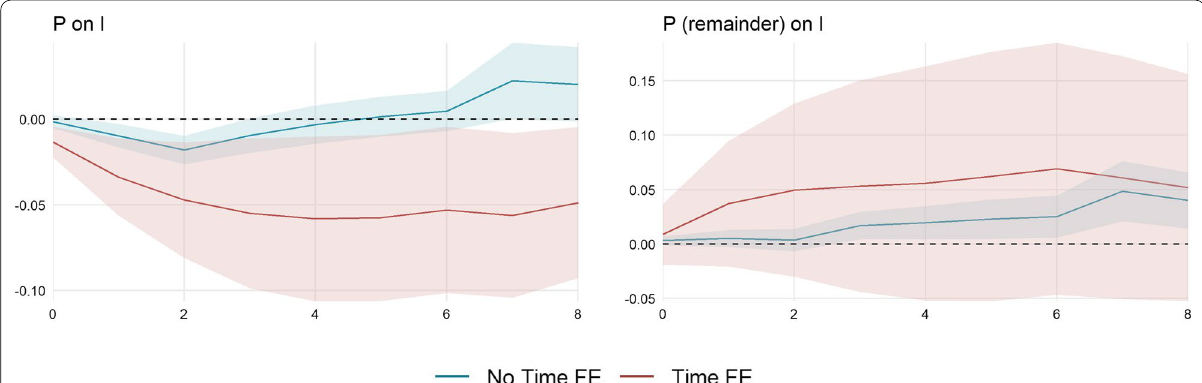
Fig. 14 LP cumulative impulse responses of infection growth I . The impulse responses are estimated using the local projection specification in (5) ln R e with (red) and without (blue) time fixed effects. In the left 4 , P (cid:31) KSI + (cid:31) KSI + (left), P (cid:31) lnNTRX , and I with p (right), B c 2 a , c 4 c 2 a , c 4 = = = = { } = −{ } panel, the sub‑categories are omitted and in the right panel, the aggregate policy index does exclude Workplace Closings (c2a) and Restrictions on Gatherings (c4) since they enter the equation individually. The data span June 22, 2020, until January 17, 2021. The shaded areas represent the 95% and 90% confidence intervals based on standard errors corrected for serial correlation. The horizontal axes depict the time horizon in weeks. The vertical axes show the level response of lnNINF